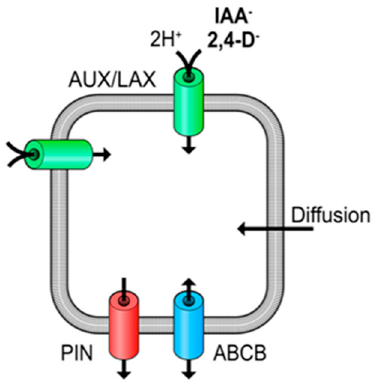
Figure 1. Schematic summary of the pathways of auxin transport in a plant cell.